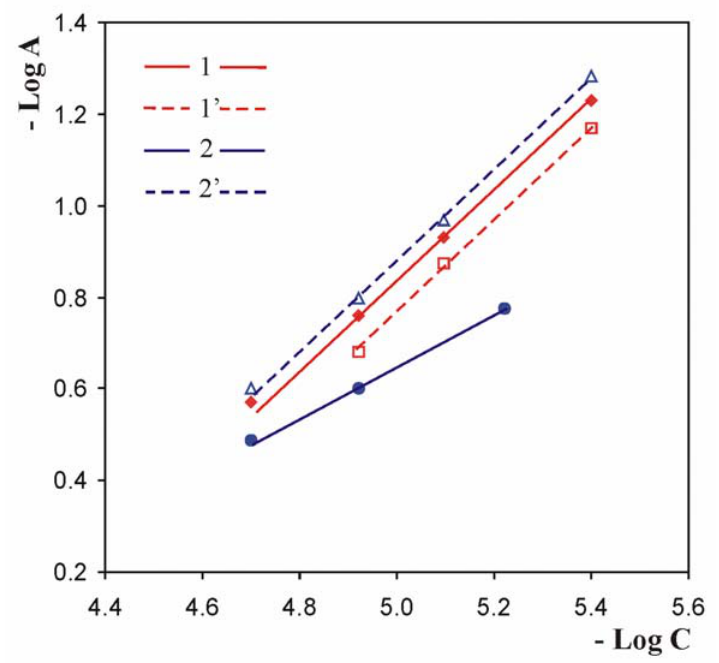
Fig. 5 Determination of the V(V) to INT (curve 1), TAR (curves 1’ and 2’) and NBT (curve 3) ratios according to the method of Bent and French: 1 - C =2x10 − 5 mol l − 1 , V ( V ) C =2x10 − 4 mol l − 1 , pH=4.75 (tg α =1); 1’ - C =2x10 − 5 mol l − 1 , C =2x10 − 4 TAR V ( V ) INT mol l − 1 , pH=4.75 (tg α =1); 2 - C =2x10 − 5 mol l − 1 , C =2x10 − 4 mol l − 1 , pH=5.5 TAR V ( V ) (tg α =0.5); 2’ - C =2x10 − 5 mol l − 1 , C =2x10 − 4 mol l − 1 , pH=5.5 (tg α V ( V ) NBT